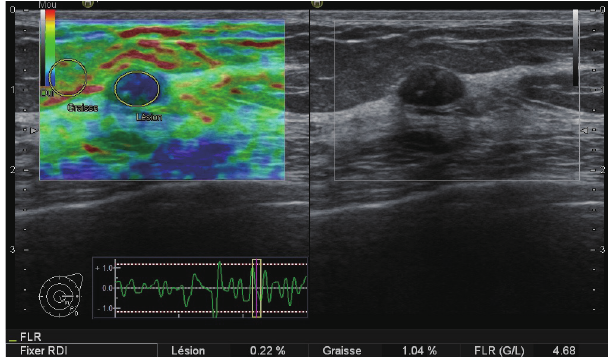
Figure 6 Fibroadenoma with low stromal cellularity in a 61-year-old woman. Strain elastography image. Mass has calcifications within it in, strain ratio was 4.68.